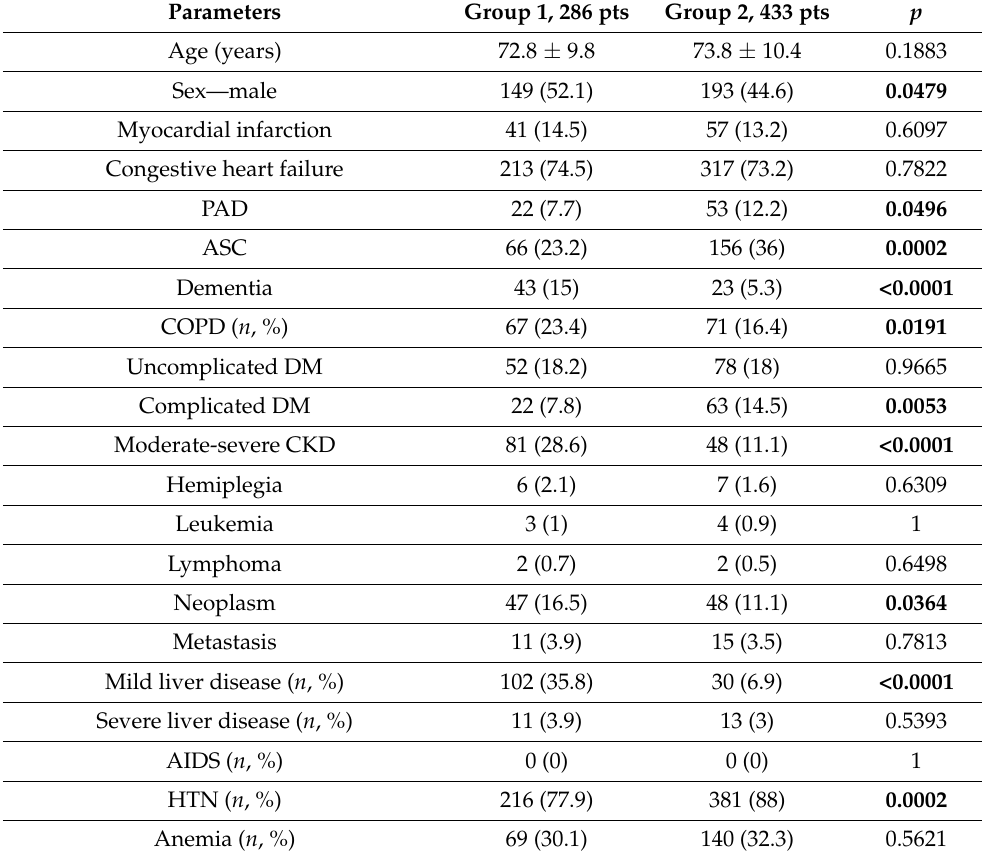
Table 2. Demographic and clinical data of patients included in the study between 2010–2011 (group 1) and 2018–2019 (group 2).